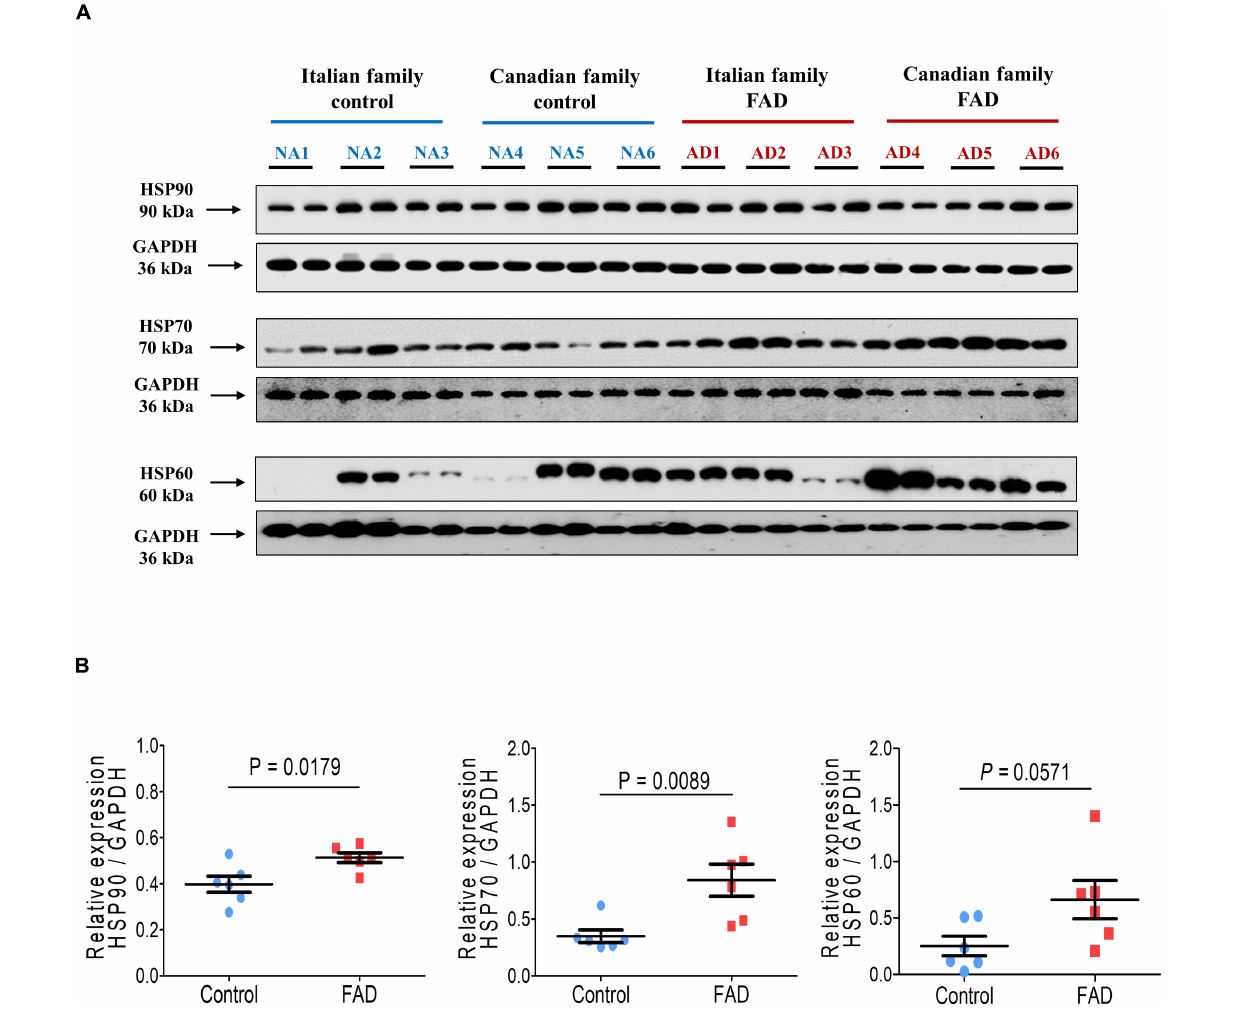
FIGURE 9 | Immunodetection of the cellular stress markers HSP90, HSP70, and HSP60 in fibroblasts from FAD individuals and control subjects (NA). Proteins were evaluated by Western blotting. (A) Blots for fibroblast protein extracts from control (6) and FAD (6) individuals. Samples were analyzed in duplicate. (B) Analysis of HSP90, HSP70, and HSP60. Protein levels were normalized against GAPDH. The points on the graphs represent the average value of the duplicates for each sample. The statistical analysis was performed with Student’s t -test.